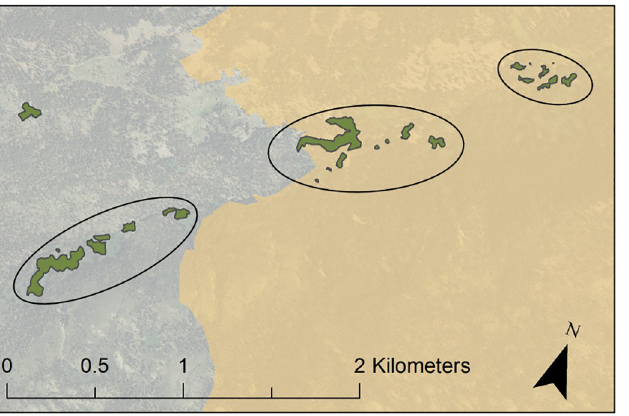
Fig 2. Example of aspen polygon grouping procedure where all polygons in close proximity (shown here within an ellipse) were grouped together as a single stand.